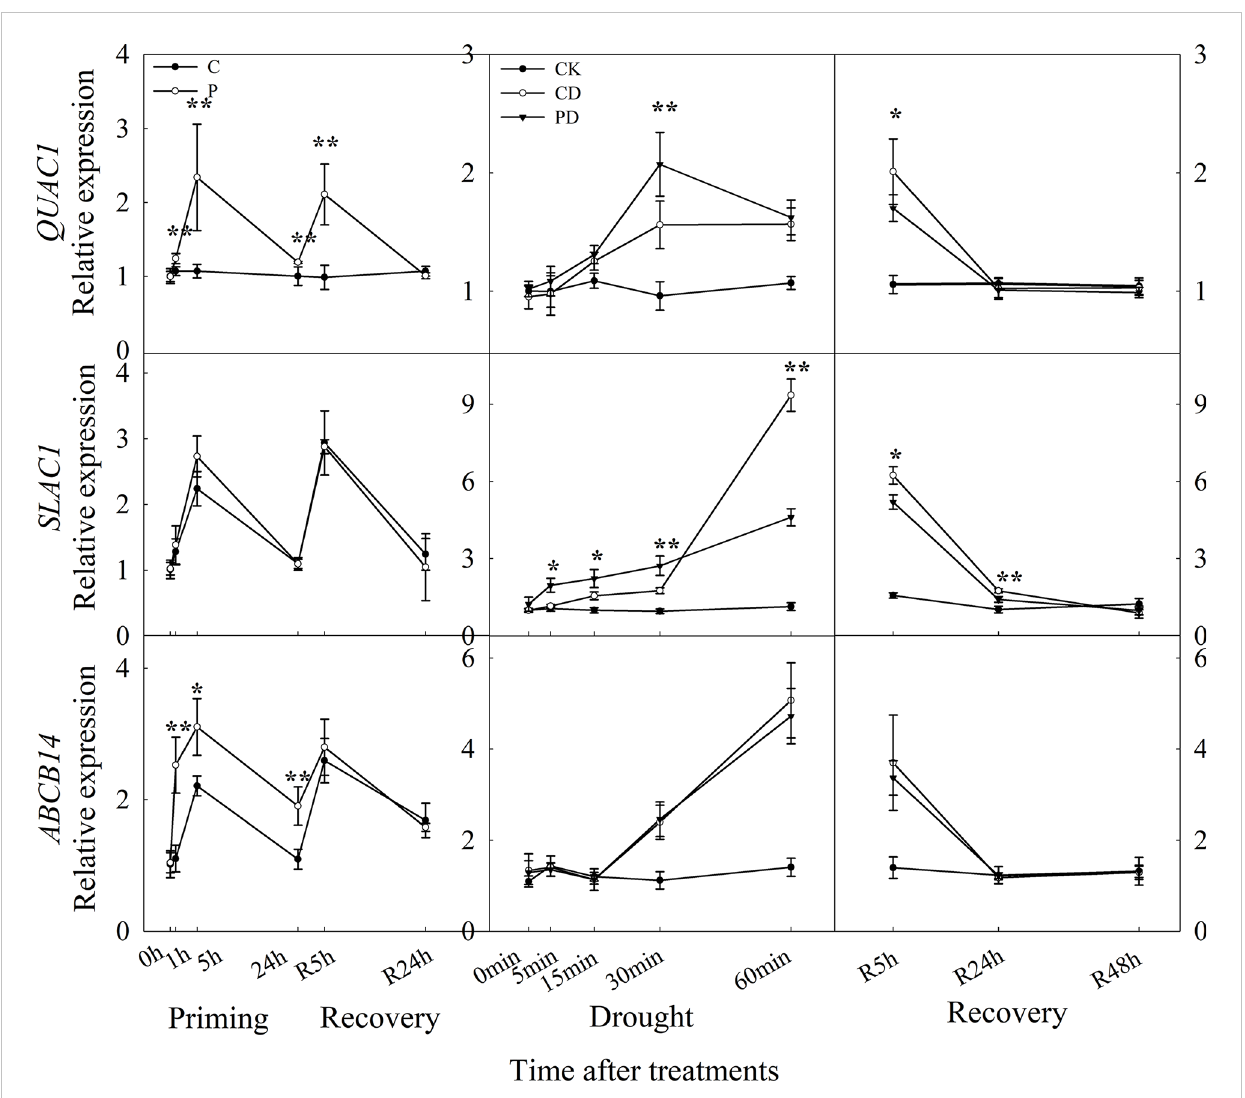
FIGURE 8 Dynamic responses of genes encoding anion fl uxes channels in leaf epidermis of wheat during “ drought priming-recovery-drought stress-recovery ” . C, no drought priming; P, priming; CK, no drought priming + no drought stress; PD, priming + drought stress; CD, no priming + drought stress. *p < 0.05; **p <